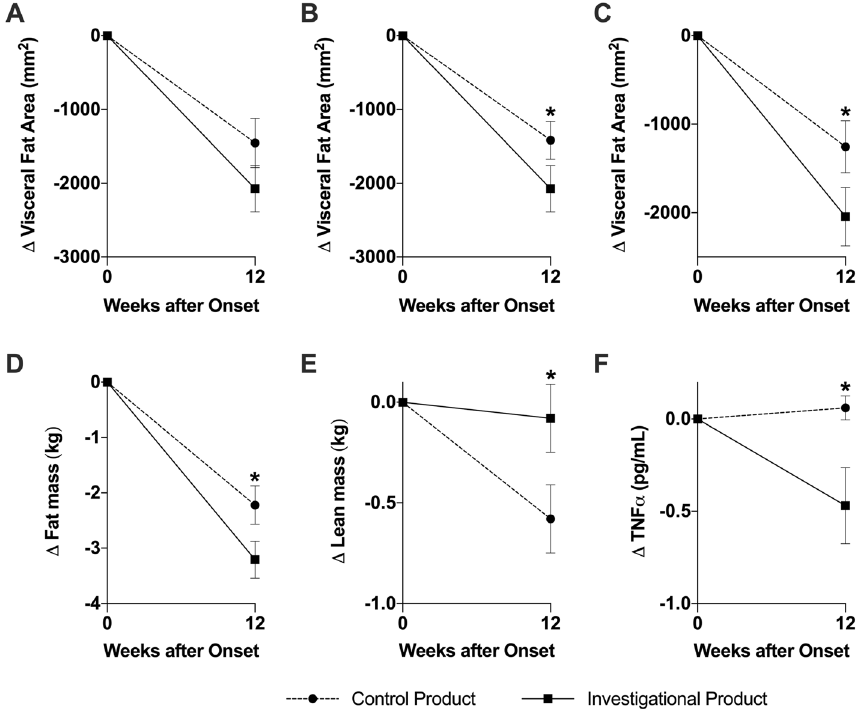
Figure 1. Investigational Product improved fat mass, maintained lean mass and reduced inflammation at week 12 post intervention. Changes in visceral fat area as established via CT scan in the ( A ) FAS population, ( B ) FAS without outliers and ( C ) PP population. Changes in fat mass ( D ) and lean mass ( E ) as established via DEXA scan and in TNFα (F) in FAS without outliers. Mean (SEM) for at least n = 51. * p < 0.05 (GEE model) Key: Circle is Control Product; Square is Investigational Product.